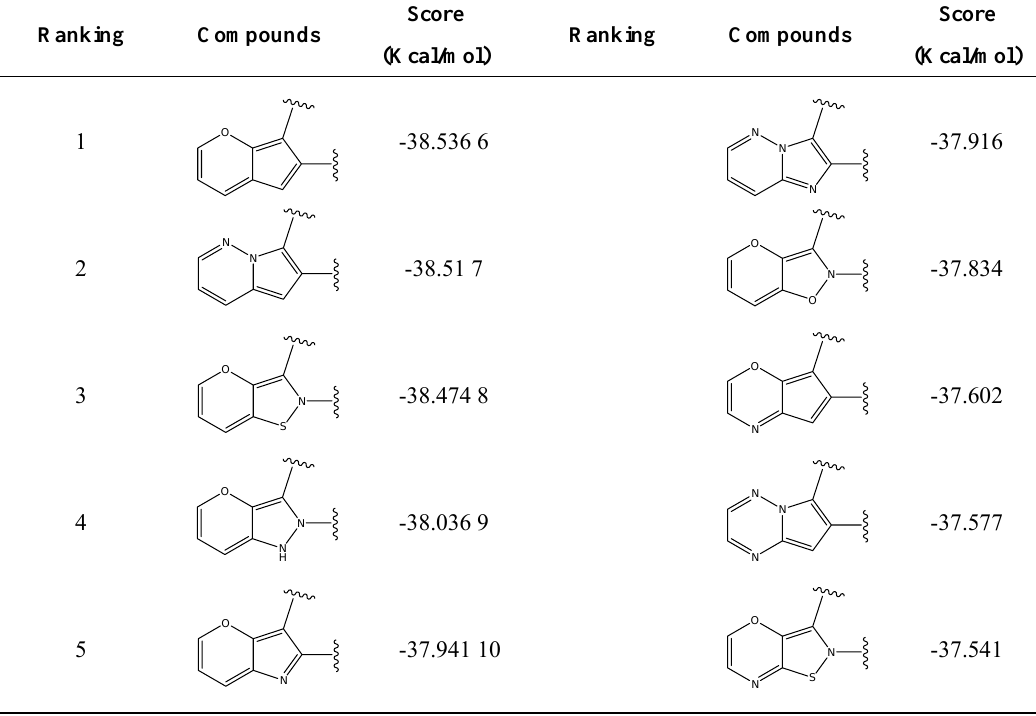
Figure 2. FPH-p38 MAN kinase co mplex analysis. Binding conformations of (a) native FPH, and (b) the top scoring compound in our